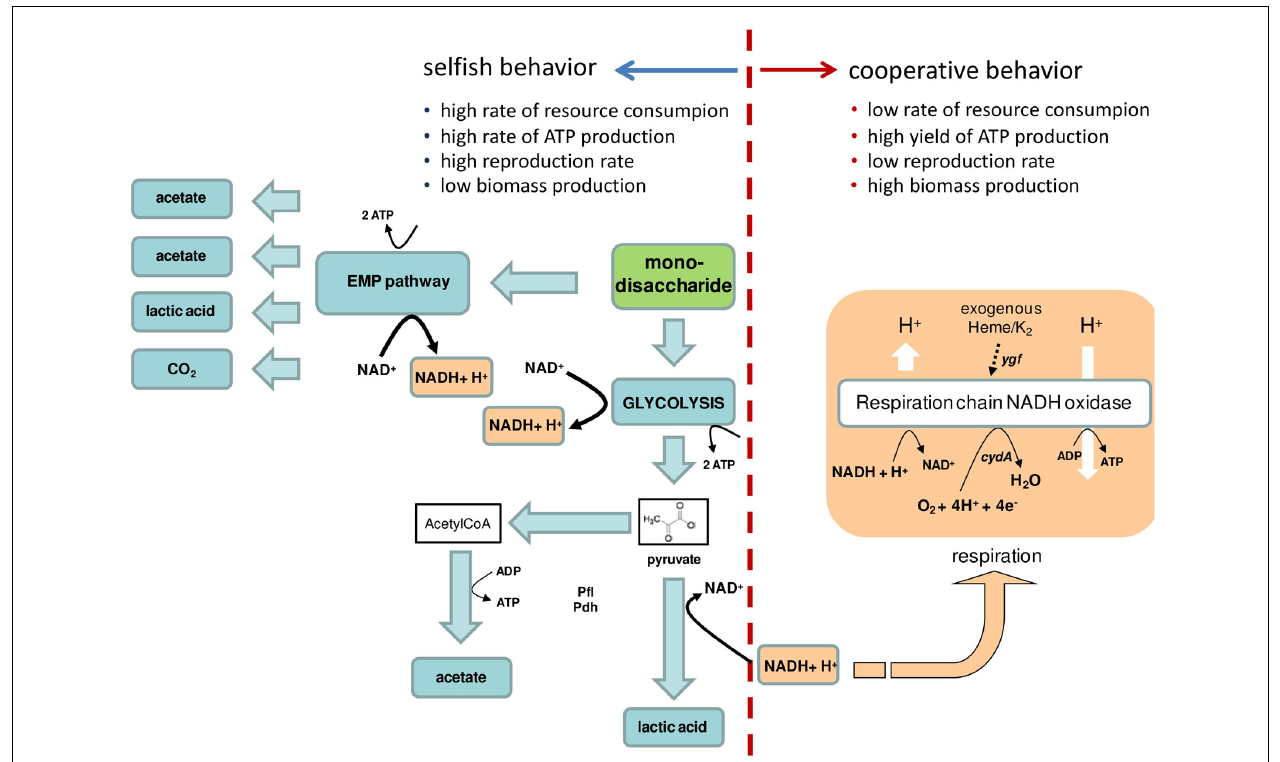
heterofermentative pathway.The yellow arrow shows the regeneration of NAD + that occurs during heme-dependent respiration. In Lactococcus lactis and in other LAB, the excess pyruvate can be metabolized by pyruvate formate lyase (Pfl), pyruvate dehydrogenase (Pdh) giving a mixed-acid fermentation with production of acetate. Ygf is the operon involved in heme homeostasis, and cydA is the gene for the cytochrome bd oxidase subunit I as described for L. lactis (Arioli etal., 2013). Arrows show the metabolic